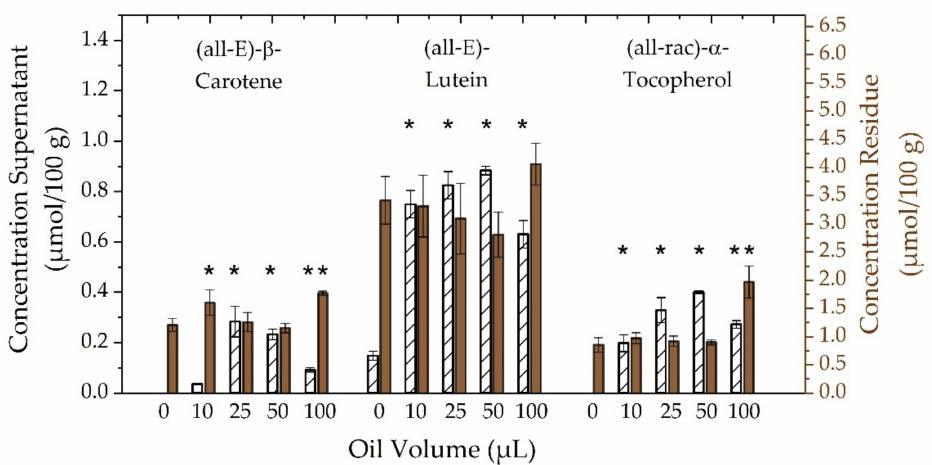
Figure 4. Dependence of concentrations of (all-E)- β -carotene, (all-E)-lutein, and (all-rac)- α -tocopherol after in vitro digestion in aqueous supernatants (left ordinate axis, white bars) and in solid residues (right ordinate axis, brown bars) on added volumes of peanut oil (0–100 µ L). One-way ANOVA with Tukey-HSD post hoc test; asterisks in the same line indicate significant differences ( p < 0.05) between digests with and without